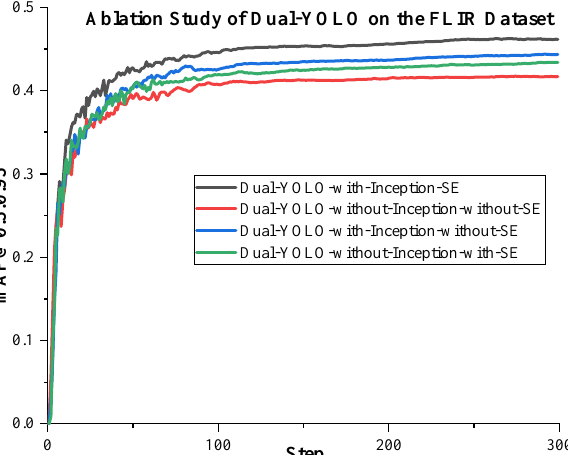
Figure 9. The mAP@.5:0.95 performance curve of Dual-YOLO during training. From the curves, we can see that Dual-YOLO has the highest accuracy when it adds Inception and the SE module together.